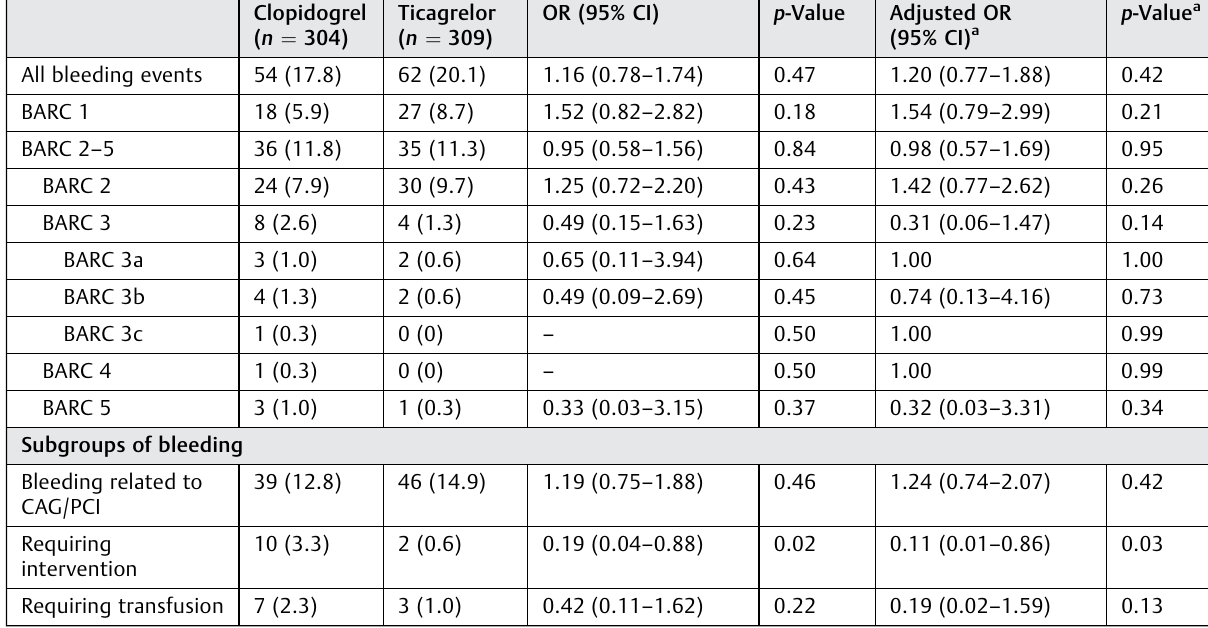
Table 2 Bleeding events during hospitalization according to treatment group